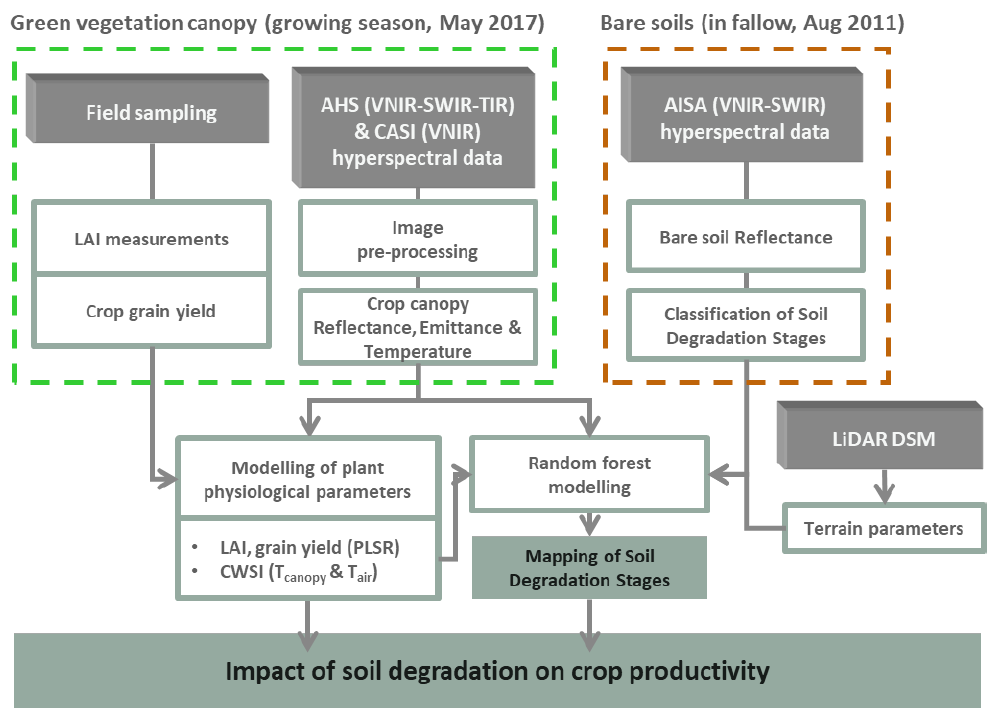
Figure 1. Schematic overview of the methodological framework applied in this study, including acquired datasets, pre-processing, and spectral modelling steps.